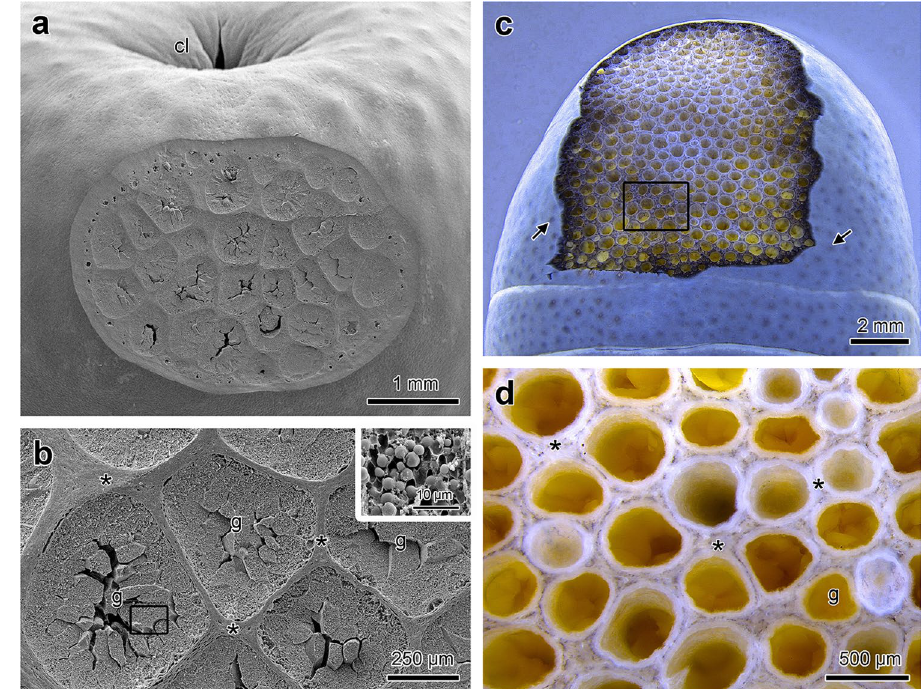
Figure 2. Anatomy of the skin of the posterior region of Siphonops annulatus . ( a ) Tangential section through the skin of the posterior tip of the body, just after the cloaca (cl), exposing a great number of large glands in the dermis. ( b ) Higher magnification of ( a ) revealing the poison glands ( g ), predominant in this region. Note the absence of lumens in the glands and the thick collagen walls ( * ) between glands. The insert shows a higher magnification of the poison stored in the glands in the form of granules. ( c ) The honeycomb architecture of the skin becomes more evident after removal of the poison from the glands. Note the presence of many pores in the skin surface (arrows), each one corresponding to a gland. ( d ) Higher magnification of the delimited region in ( c ) showing the honeycomb arrangement and the collagen walls ( * ), which remain unchanged after poison removal. Scanning electron microscopy ( a − b) , stereomicroscopy ( c − d